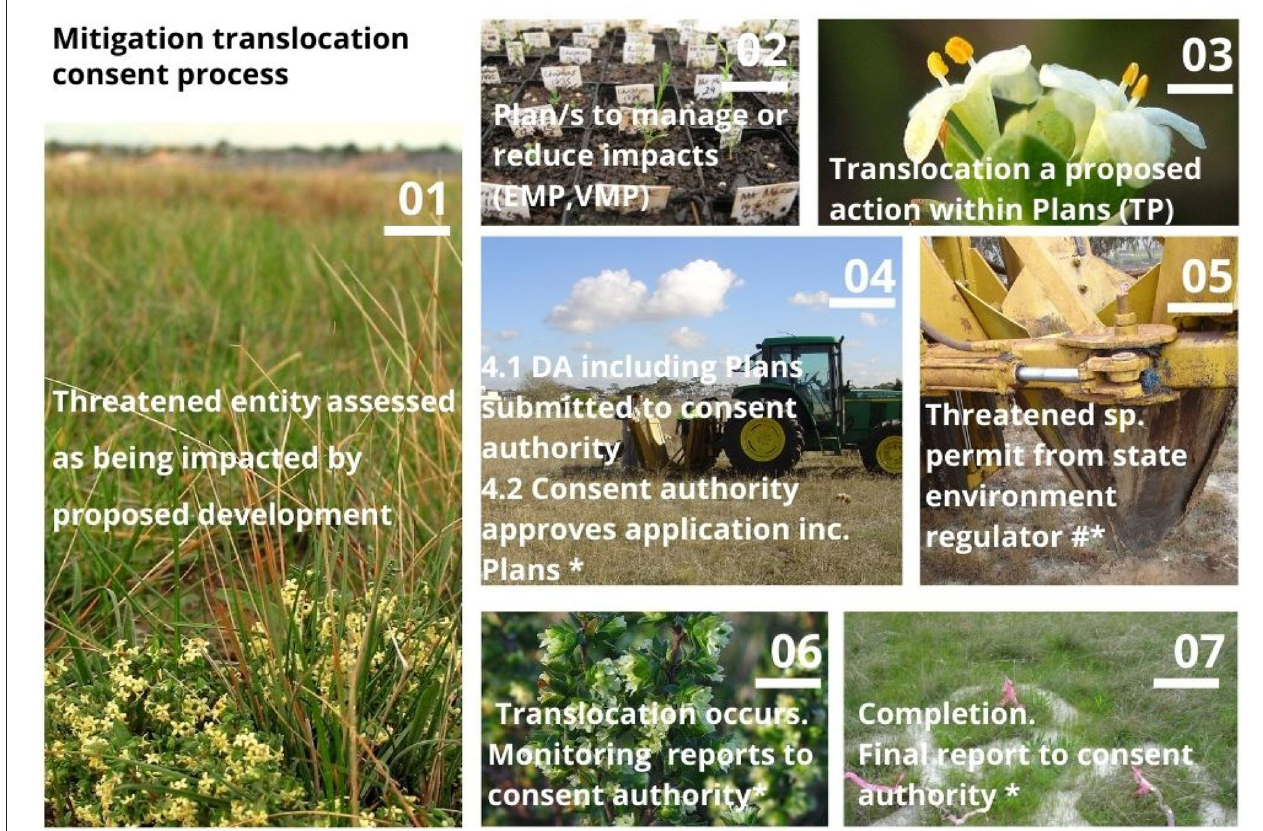
FIGURE 1 | Opportunities within the Development Application workflow for collating mitigation translocation data. Numbers represent sequence of DA process. DA, development Application; EMP/VMP, environmental/vegetation management plan; TP, Translocation Plan. For mitigation translocation the DA consent gives indirect approval for the translocation, via the acceptance of the Plans. Image credit; Dr Debbie Reynolds and Steve Mueck. *Opportunity for translocation data to be recorded in accessible public data base. # Usually different authority to those issuing DA